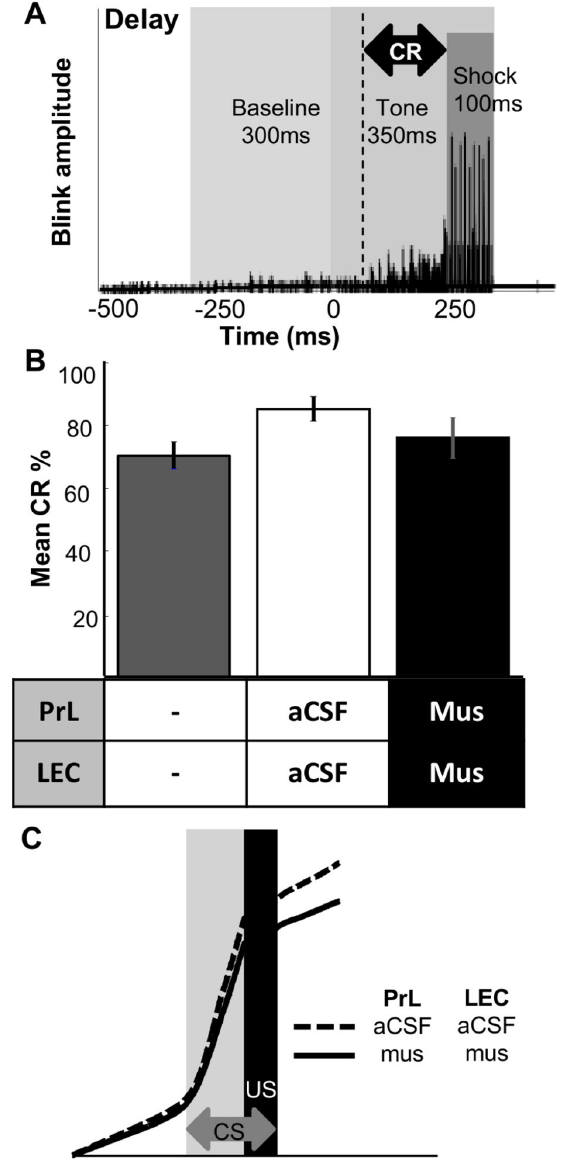
Figure 3. Prefrontal-entorhinal disconnection did not impair memory expression in delay